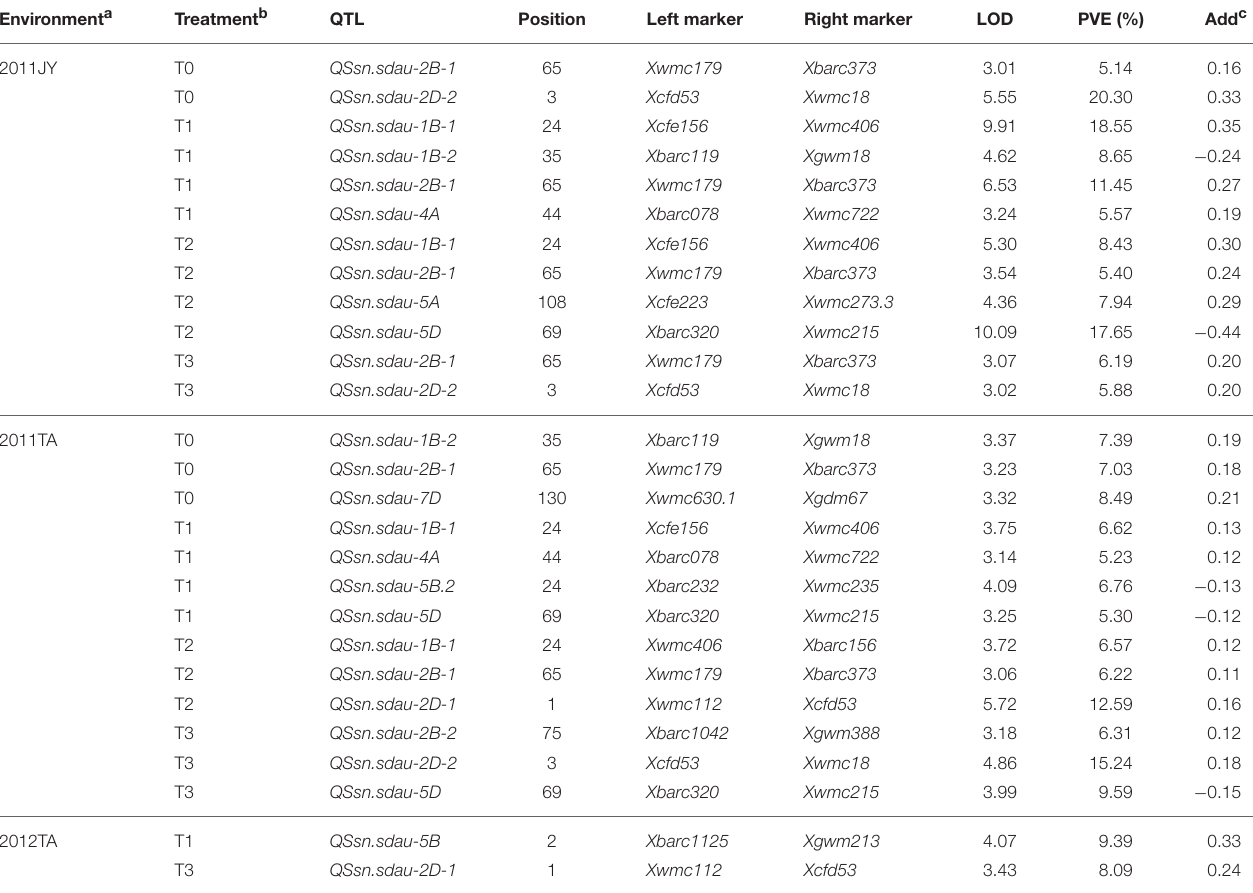
a and b are the same as those for Table 3 . c Epistatic